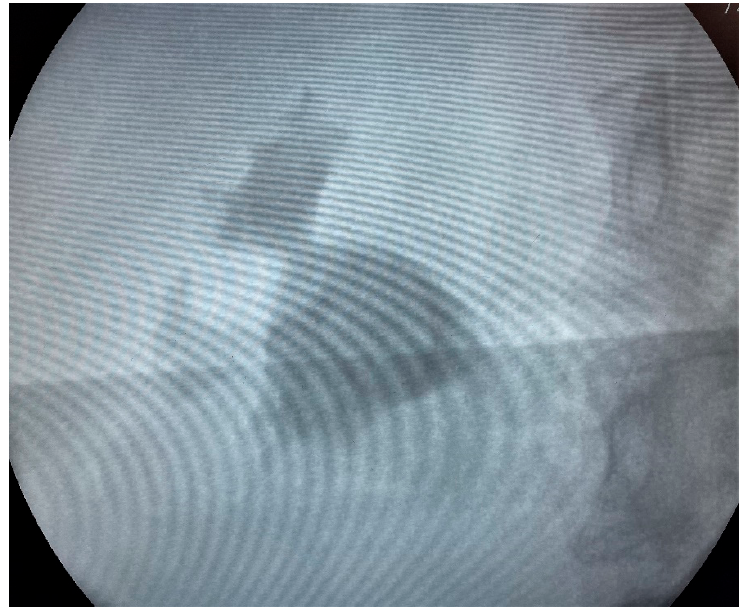
Figure 1. Fluoroscopy image of the pelvicalyceal system showing the stone.